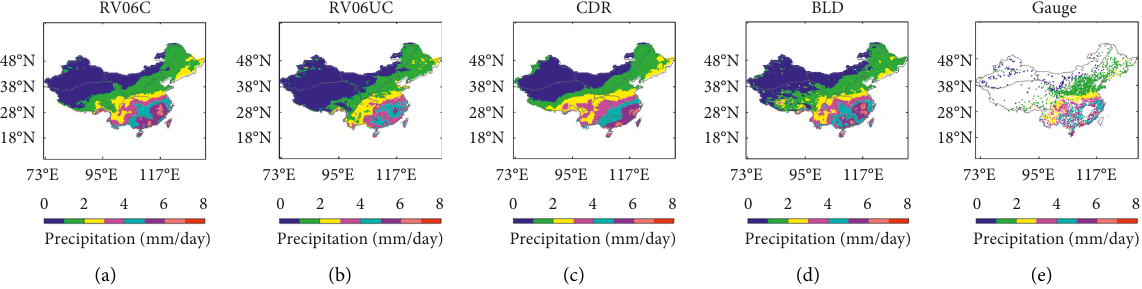
Figure 2: Spatial distribution of average daily precipitation (mm/day) derived from (a) RV06C, (b) RV06UC, (c) CDR, (d) BLD, and (e) in situ gauges over Mainland China from March 2014 to June